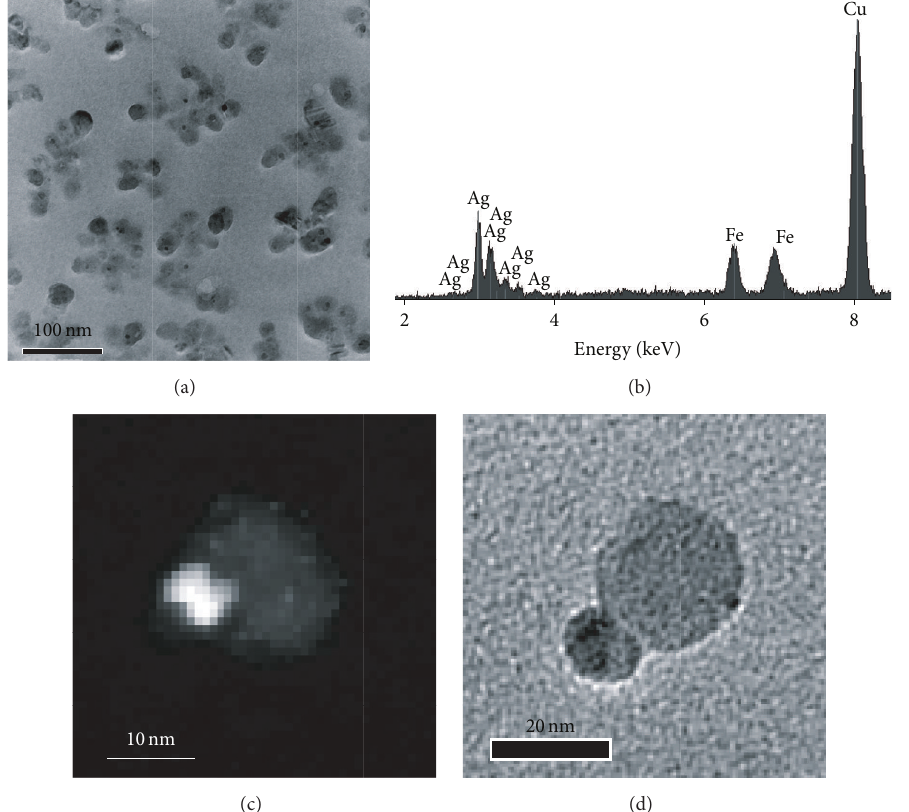
Figure 1: (a) TEM image of 𝛼 -Fe 2 O 3 -Ag dumbbell-like nanoparticles, (b) EDS chemical analysis (c) 𝑍 -contrast image (HAADF), and (d) bright field TEM image of an individual 𝛼 -Fe 2 O 3 -Ag